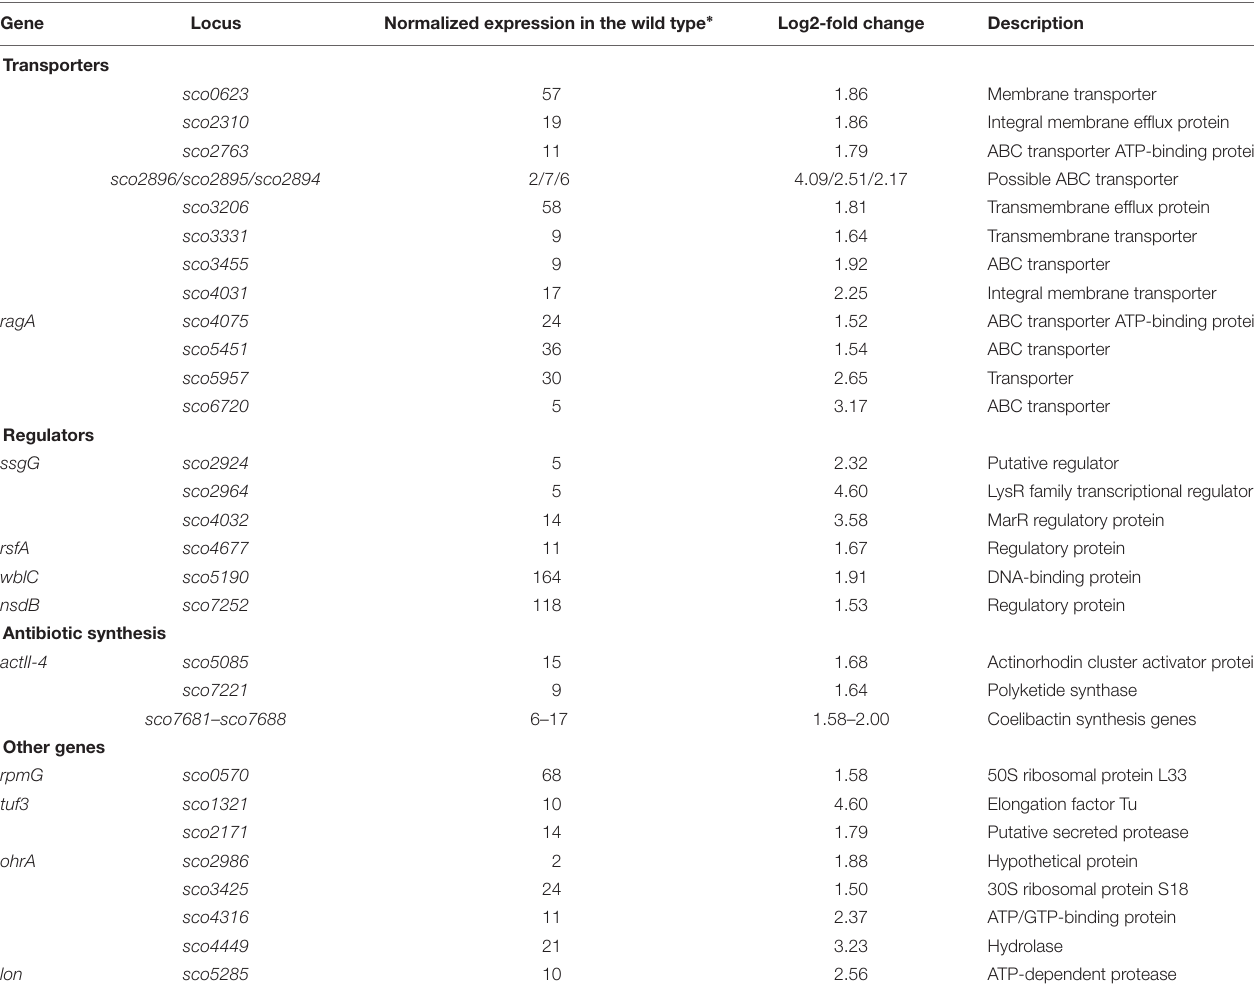
Gene Locus Normalized expression in the wild type ∗ Log2-fold change